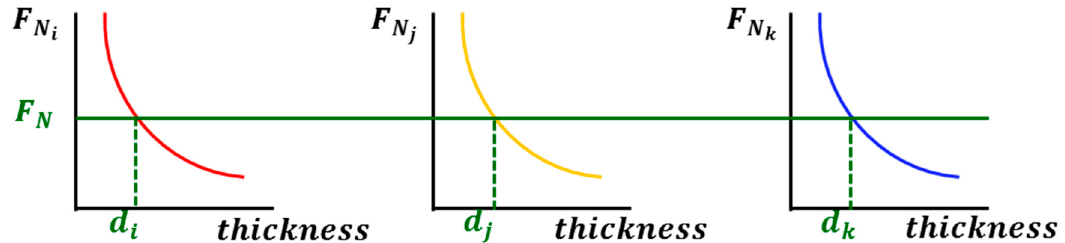
Figure 2. Schematic diagram of compression tests for each fabric layer in the multi-layered fiber preform.